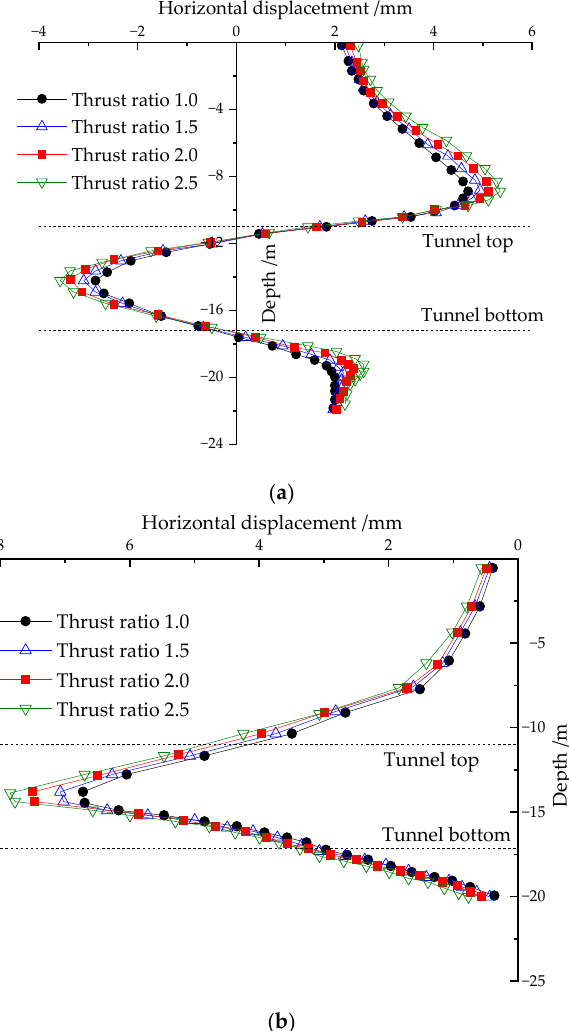
Figure 8. Curves of horizontal displacement of surrounding soil under various thrust ratios: ( a ) outer side of curved tunnel axis; ( b ) inner side of tunnel.